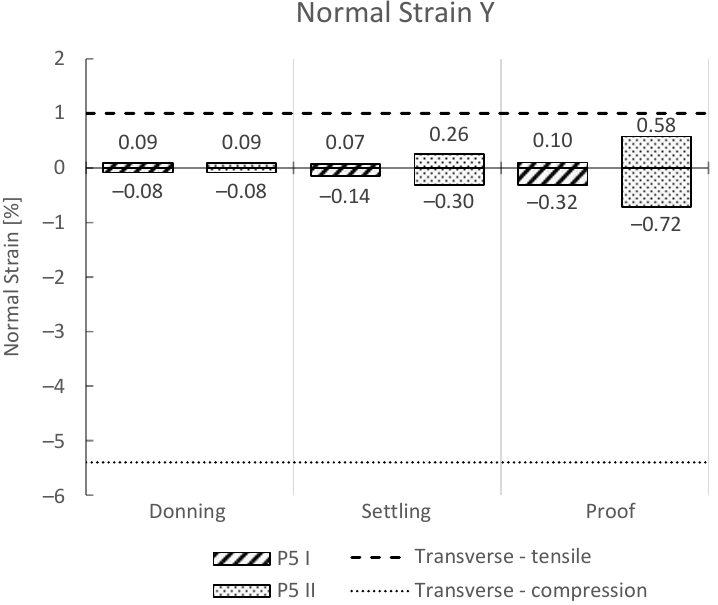
Figure 8. Results of normal strain in the y-axis. The negative values represent compression, while the positive values represent tensile strain. Additionally, the transverse yield strain is shown with horizontal dashed lines.